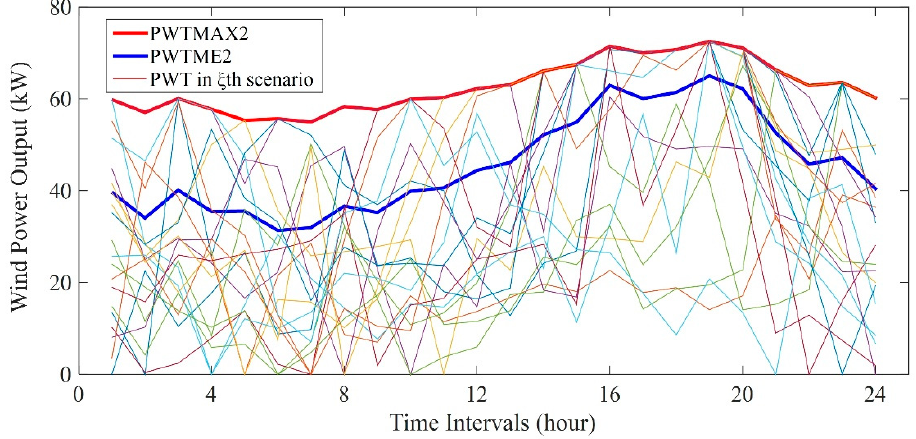
Figure A5. The generated stochastic scenarios for wind power outputs on the typical summer day.